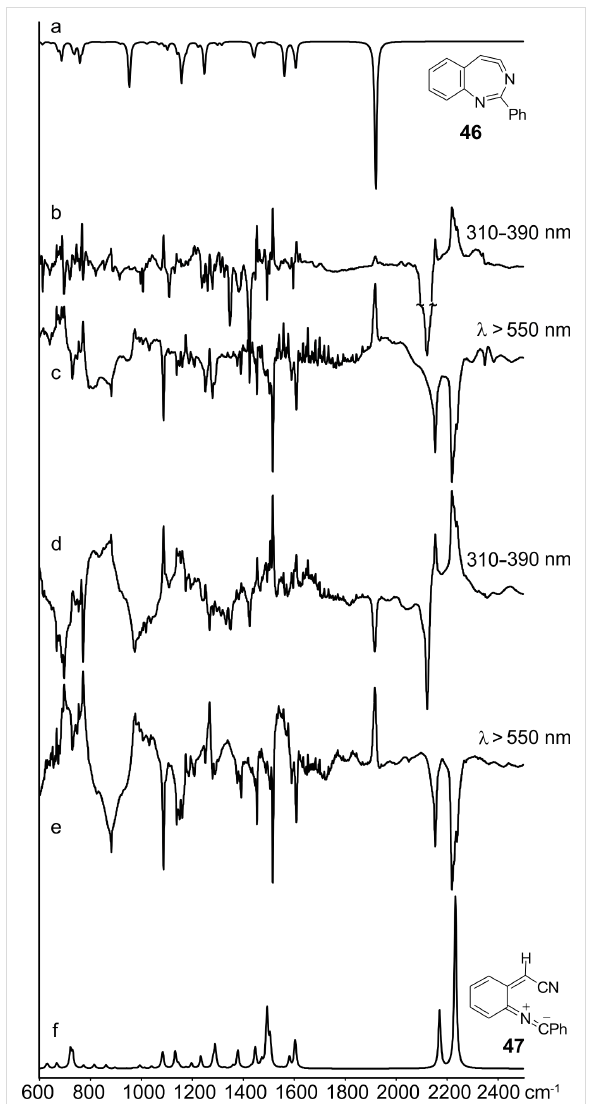
Figure 2: IR difference spectra from the photolysis of 3-azido-2- phenylquinoline ( 44 ) in Ar matrix. (a) Calculated spectrum of 46 . (b) Initial difference spectrum after 240 s; the negative peaks are due to the azide. (c)–(e) Further irradiation as indicated for 900, 400 and 600 s, respectively. (f) Calculated spectrum of 47 . Ordinate in arbitrary absorbance units. See also Figures S1–S3 in Supporting Information File